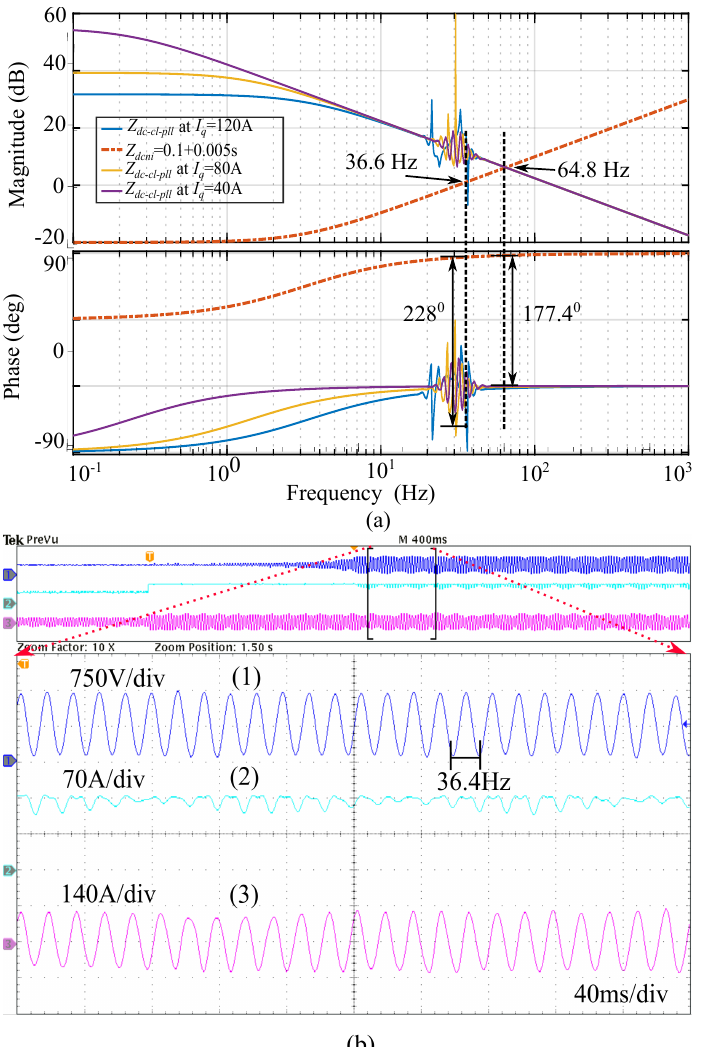
appeared across the dc link capacitance. The frequency of oscillations in the DC link voltage is noticed at 36.4 Hz. This indicates that derived models are accurate.